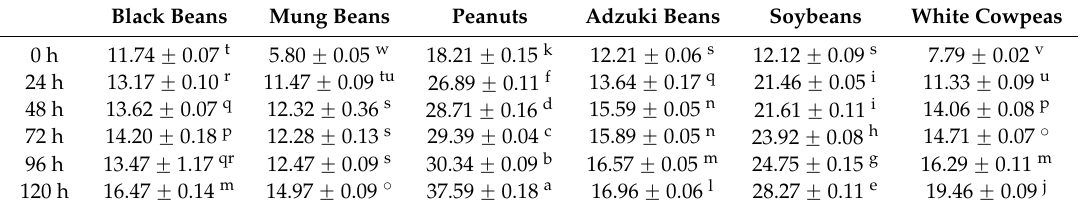
Table 1. Total phenolic content (mg ¨ GAE ¨ g ´ 1 dry weight) of ungerminated and germinated legumes. Black Beans Mung Beans Peanuts Adzuki Beans Soybeans White